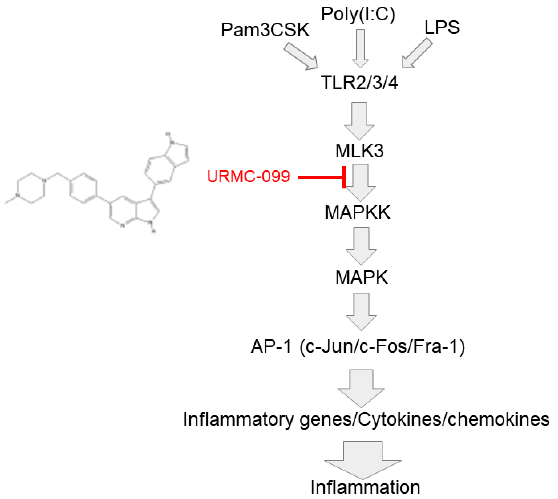
Figure 5. Schematic summary of inflammation-regulatory role of MLK3.